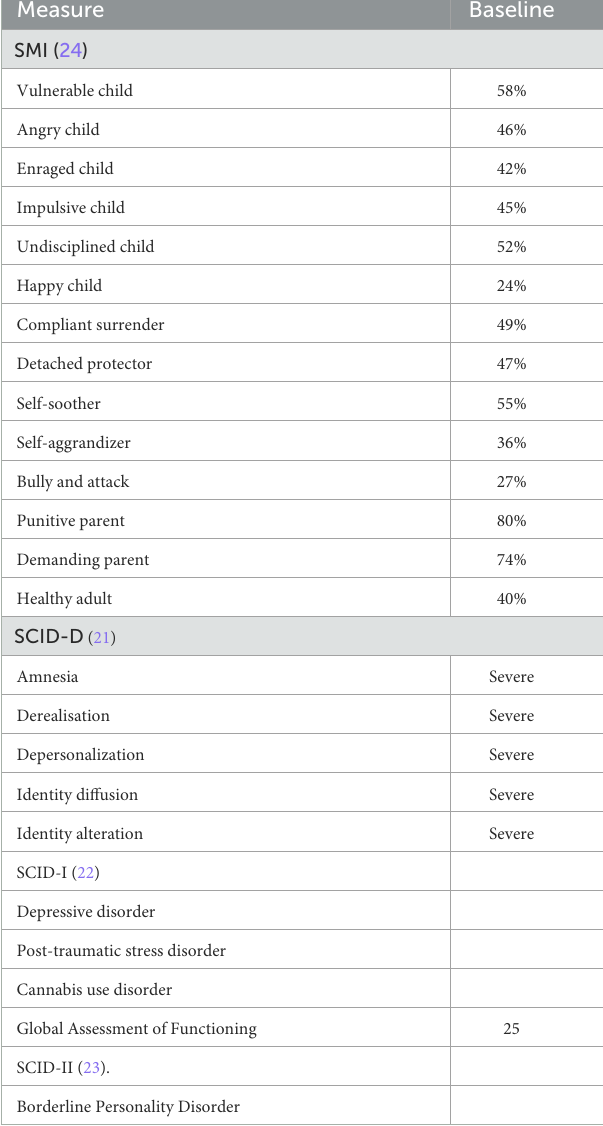
TABLE 1 Results of baseline